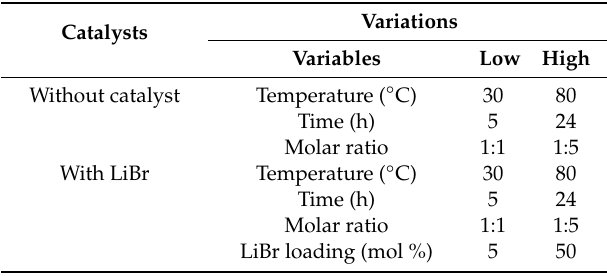
Table 1. Overview of